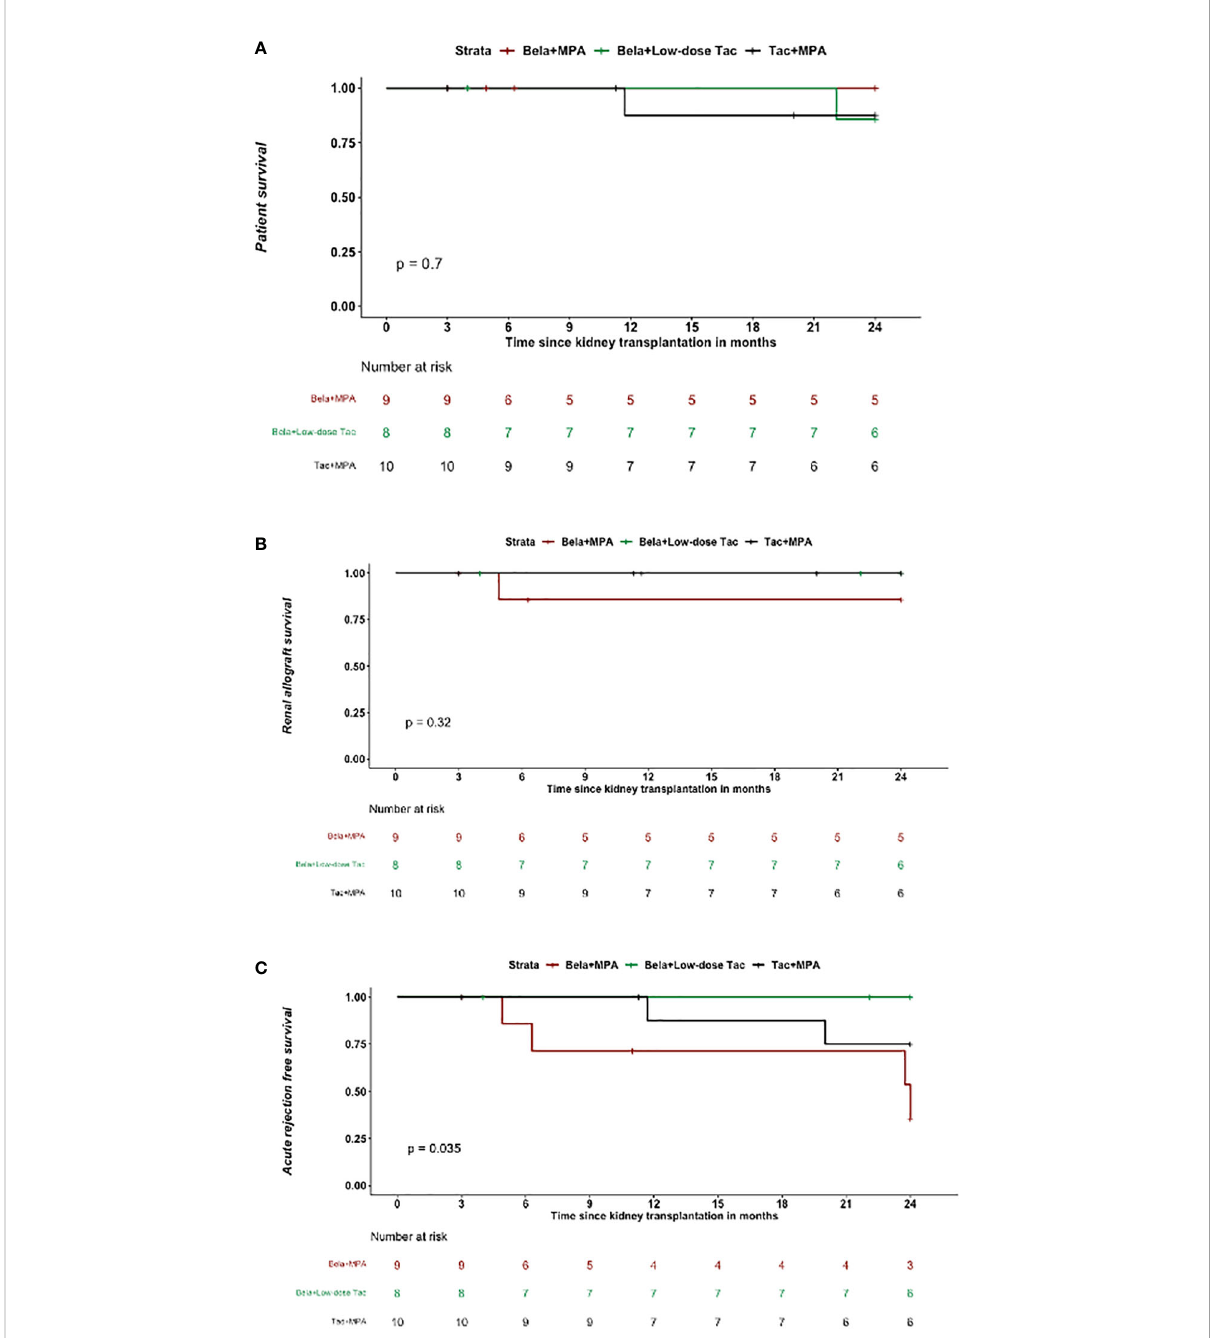
FIGURE 3 Patient and graft survival and incidence of acute rejection: (A) Kaplan-Meier curve depicting the time to occurrence of death in the three treatment groups shows no signi fi cant difference of death rate amongst the three treatment groups; (B) Kaplan-Meier curve depicting the time to occurrence of renal allograft loss in the three treatment groups shows that there was one graft loss in the Bela+MPA group, and no allograft loss seen in the Bela+Low dose Tac and Tac+MPA groups; (C) Kaplan-Meier curve depicting the time to occurrence of BAPR in the three treatment groups shows that Bela+Low dose Tac group was associated with the highest BPAR free survival